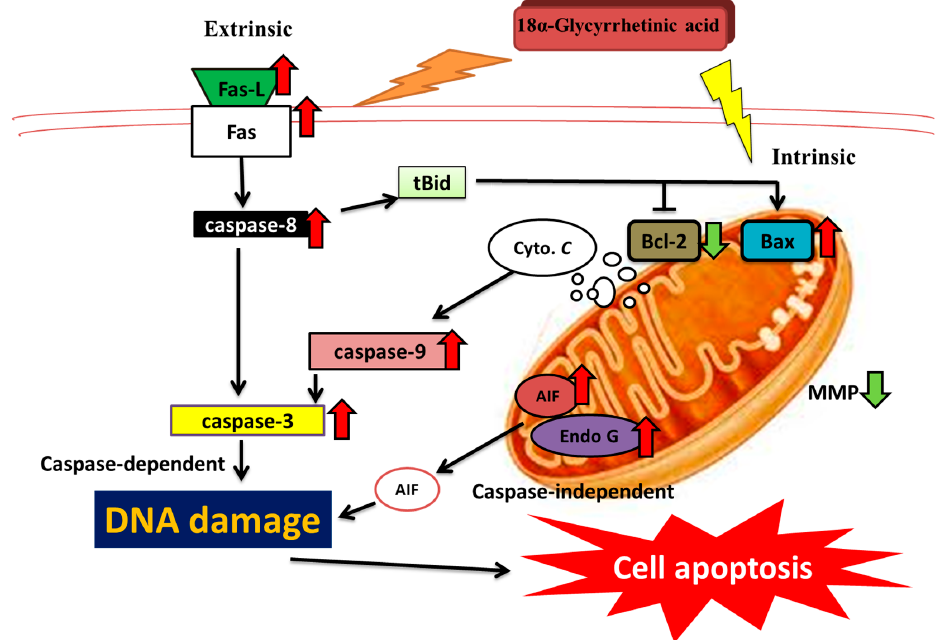
Figure 6. The possible signaling pathways for 18 α -GA induced apoptosis in human leukemia HL-60 cells in vitro.